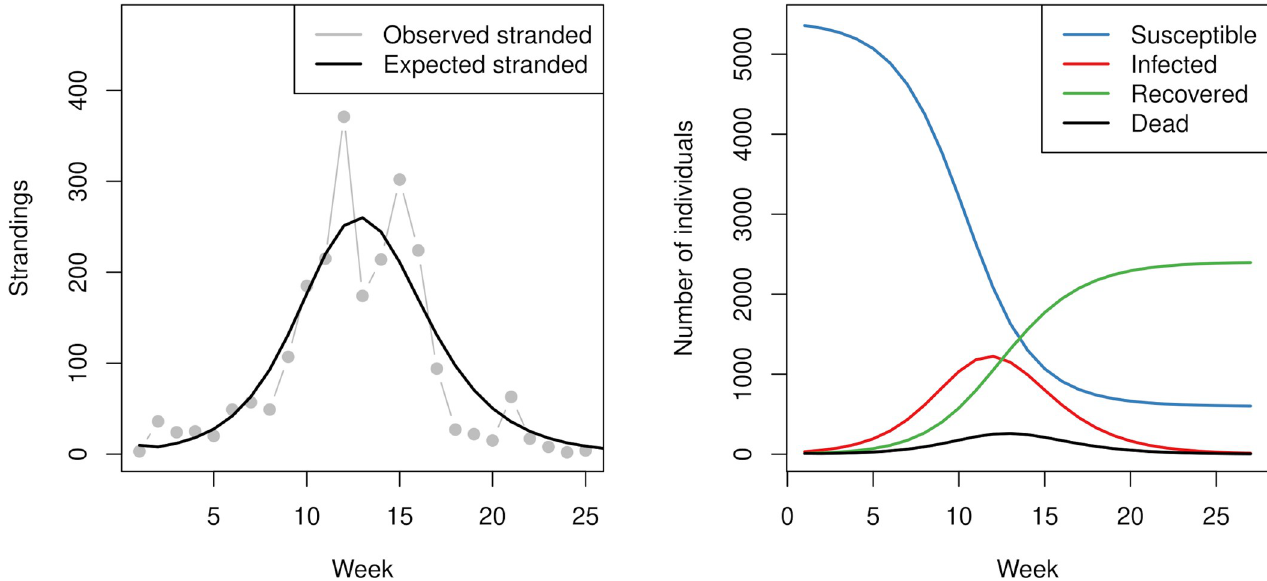
Fig 5. Panel A illustrates the observed (grey points) and expected number of strandings from the SIRD model (black line). All deaths are assumed to lead to strandings. Panel B illustrates the expected number of susceptible (blue), infected (red), recovered (green), and dead (stranded) seals (black) over the course of the